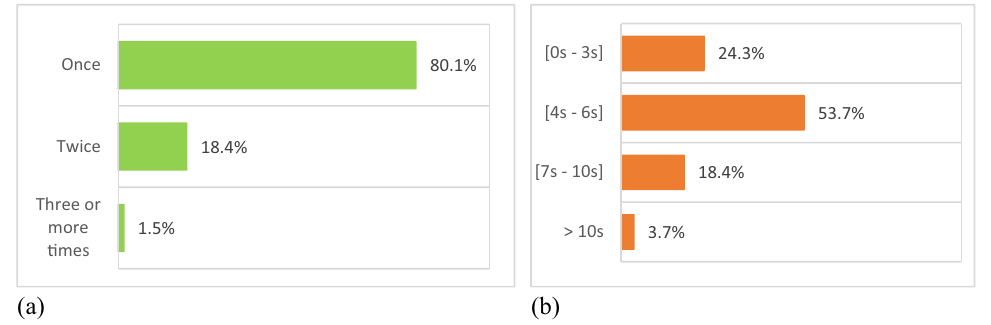
Figure 5: Results for the questions: “ During shopping in a supermarket, when choosing food products displayed in a refrigerated or frozen cabinet on an average, how many times do you open the door until you choose, decide, or reach the desired product? ” ( a ) and “… on an average, how long do you keep the door open ( from open to close ) to reach the desired product? ” ( b ) .